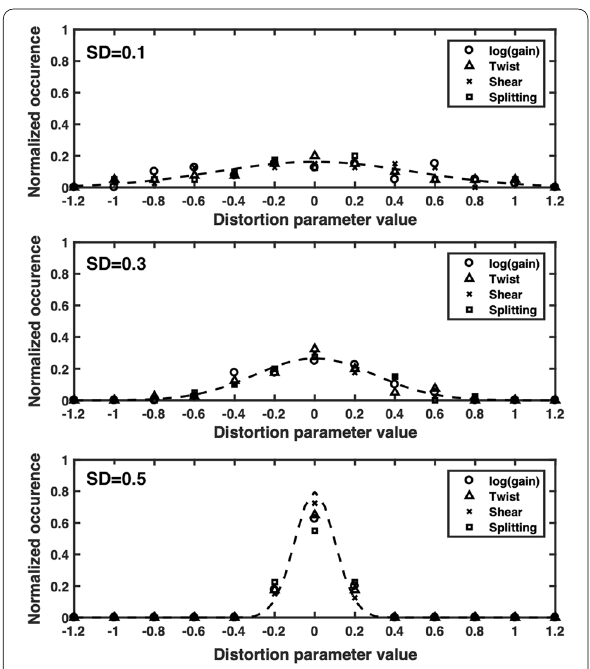
Fig. 4 Distribution of GB distortion parameters ( g , t , e , s ) for SD values of 0.1, 0.3, and 0.5. Each distribution is compared with the probability density function of the theoretical normal distribution for the given SD (dashed curves)